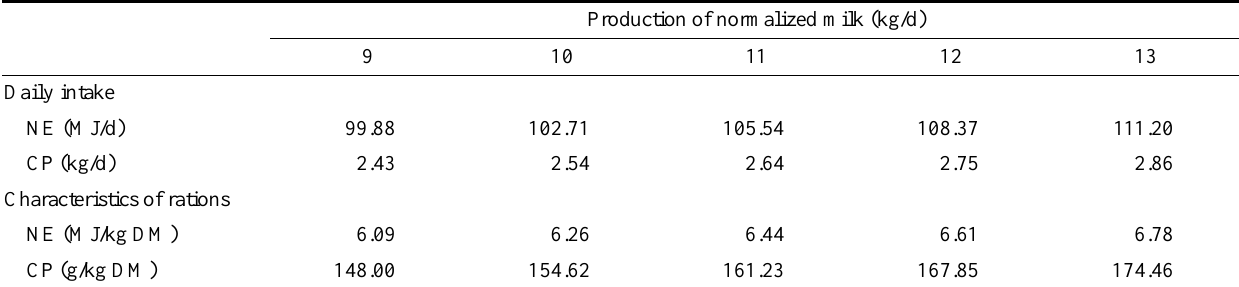
Table 4. Daily intake of net energy and crude protein in the first ninety days of lactation and indicative characteristics of rations 1 Production of normalized milk